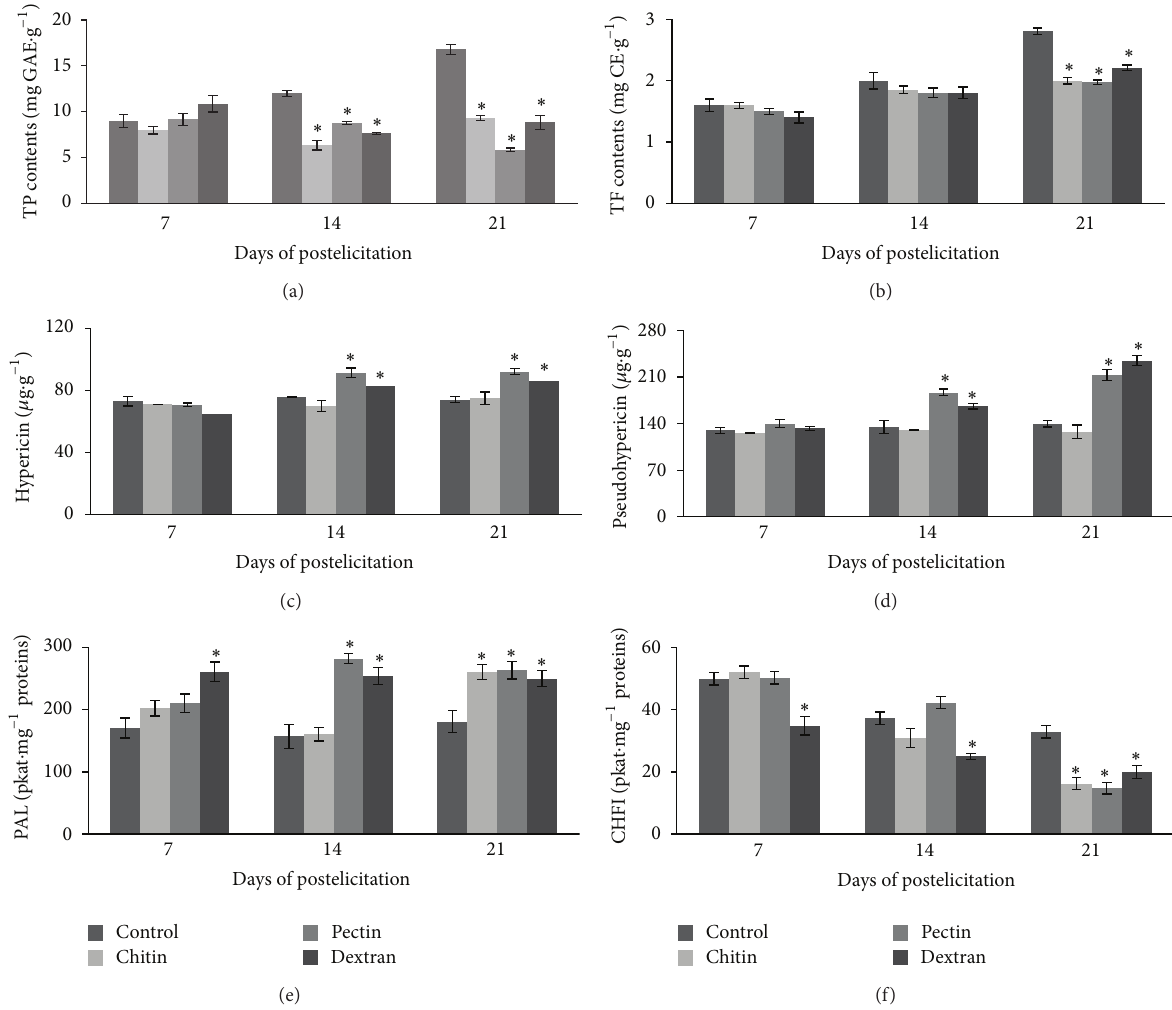
Figure 1: Effects of polysaccharide elicitors on the production of (a) phenolics, (b) flavonoids, (c) hypericin, (d) pseudohypericin, and enzymatic activities of (e) phenylalanine ammonia lyase and (f) chalcone-flavanone isomerase in Hypericum perforatum shoot cultures. TP: total phenolics; TF: total flavonoids; PAL: phenylalanine ammonia lyase; CHFI: chalcone-flavanone isomerase. Level of significance is ∗ 𝑃 < 0.05